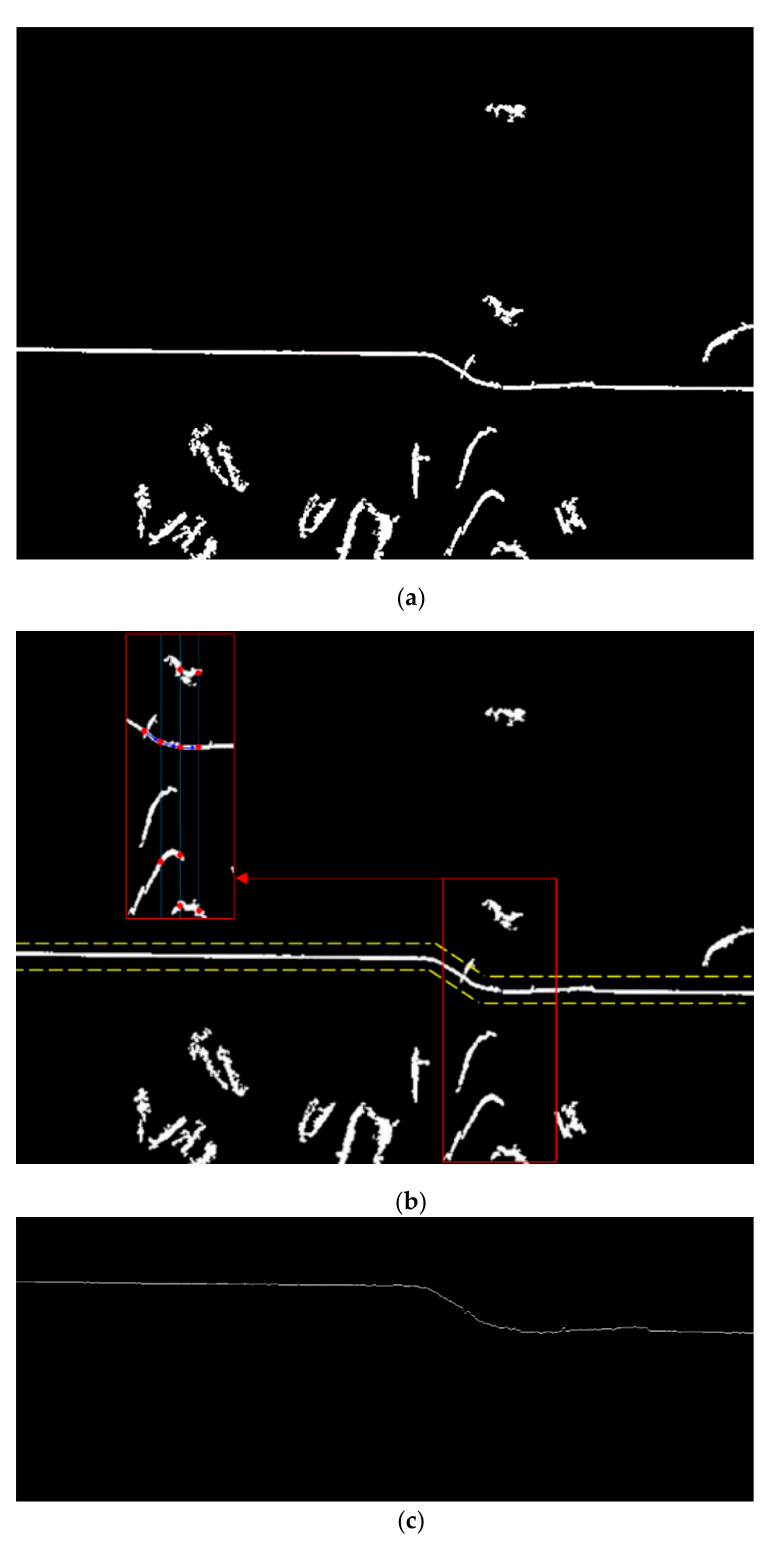
Figure 5. Contouring and thinning operations. ( a ) Contouring operation; ( b ) Thinning operation; ( c ) Resultant laser line after image processing.